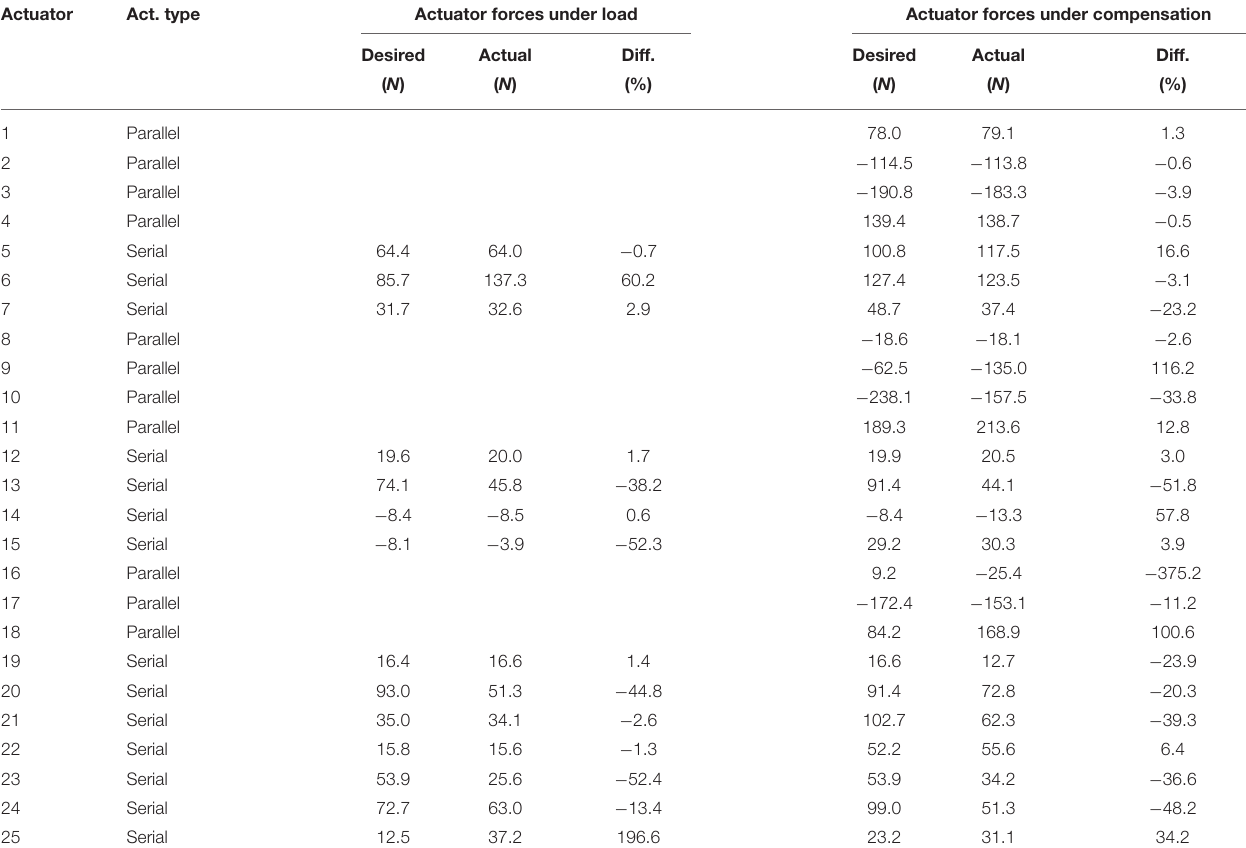
TABLE A2 | Table displaying the data of Figure 8